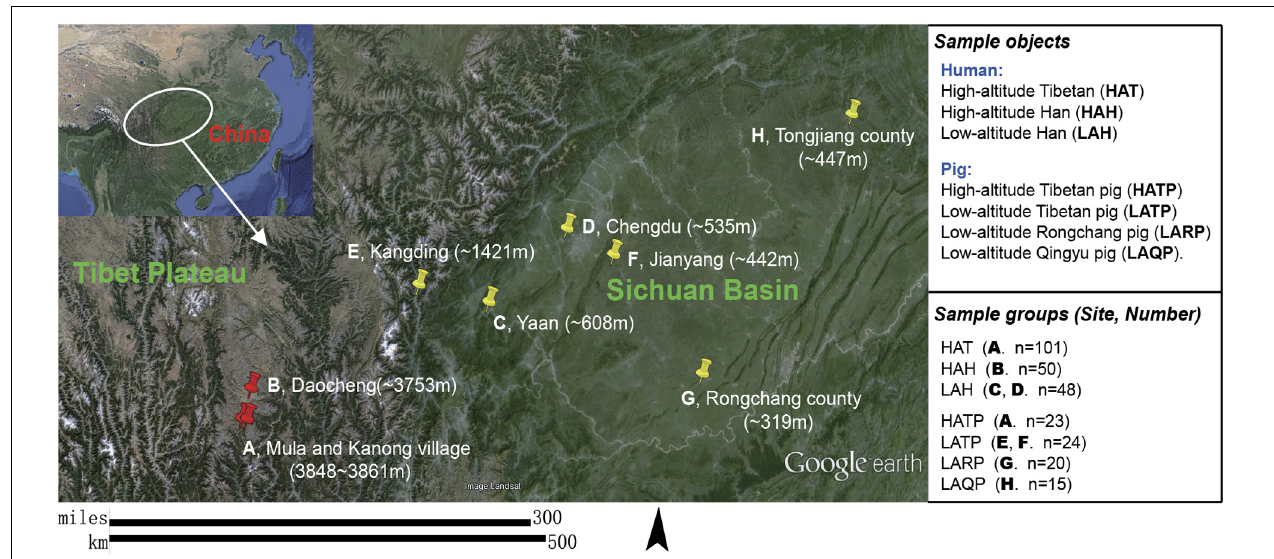
FIGURE 1 | Subject groups and sampling locations. Three high-altitude and seven low-altitude sampling areas were labeled precisely on the Google Earth map using red and yellow indicator marks. (A) Two Tibetan villages in different river valleys of a mountainous area (separately marked on map) where both humans and pigs were sampled. (B–D) City area where urban Han residents were sampled. (E,F) Two pig-farms located in the suburbs of low-altitude cities; Tibetan pigs were transferred from the highland and raised at these farms for 6 months to 2 years. (G) A pig farm in the suburb of Rongchang county raising Rongchang pedigreed pigs. (H) Farmlands on hills near Tongjiang county where Qingyu pigs are raised in a fenced-in open area.